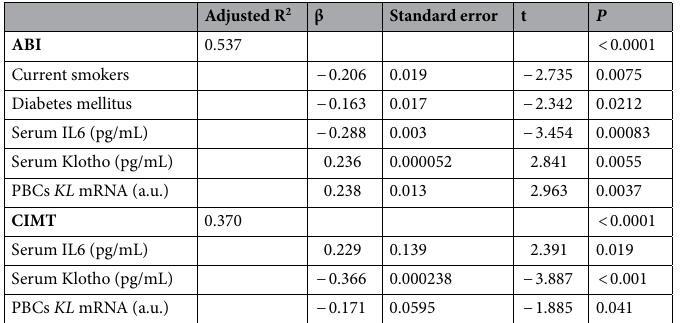
Table 3. Multiple backward stepwise regression analysis for ABI and CIMT as dependent variables. ABI ankle-brachial index, CIMT carotid intima-media thickness, PBCs peripheral blood cells, IL interleukin, KL Klotho gene.